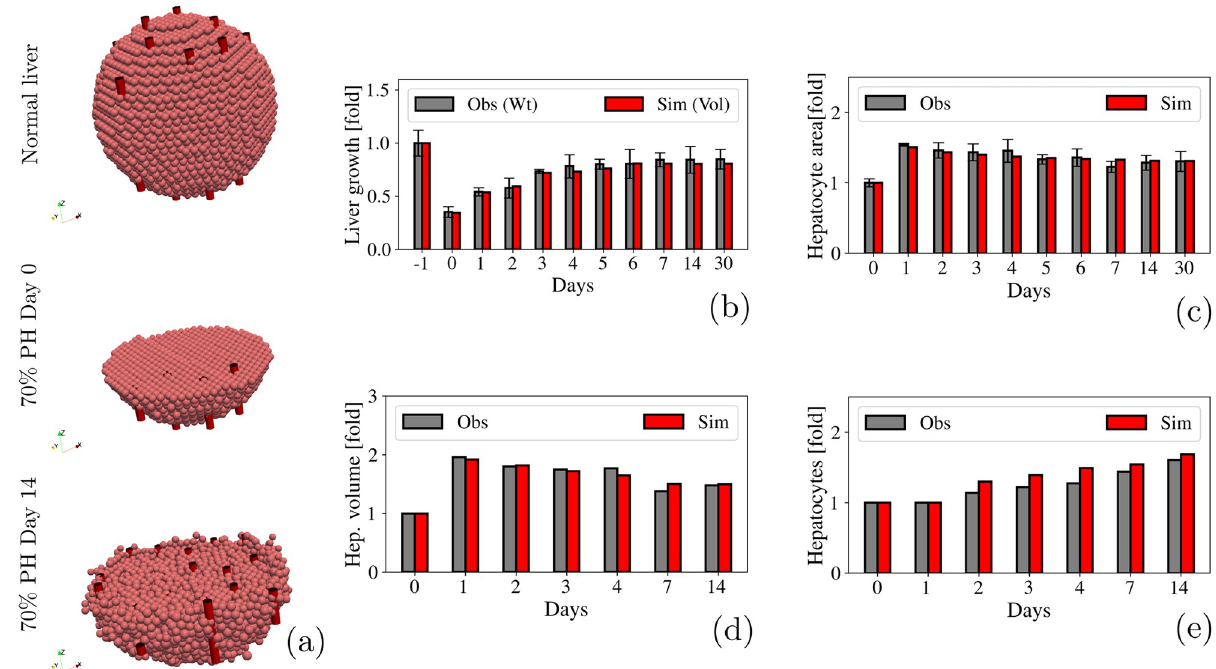
Fig 6. 70% PH. (a) Qualitative representation of the liver regeneration process after a 70% PH. (b) Fold-increase in the liver size. Observational data is shown in gray and represents the weight of the liver measured by Miyaoka et. al [44, 45]. Simulated data is shown in red and represents the liver volume. (c) Quantification of the hepatocytes area during liver regeneration. (d) Quantification of the hepatocytes volume during liver regeneration. (e) Fold-increase in the number of hepatocytes during liver